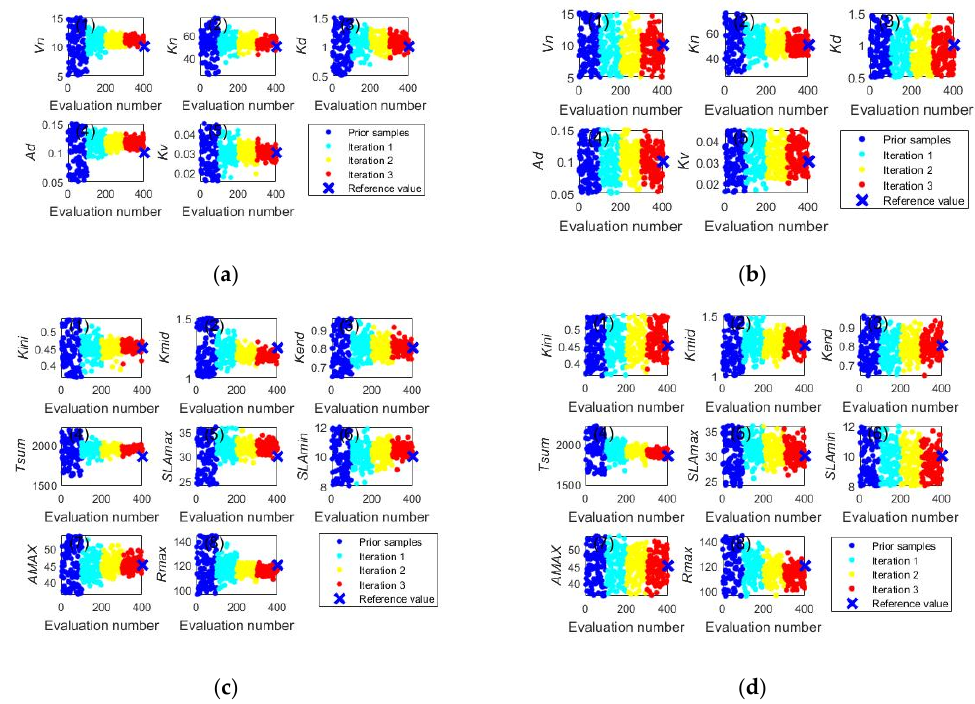
Figure 3. Trace plots of soil nitrogen transformation parameters and crop parameters obtained by the ILUES ( left column ) and ESMDA ( right column ) algorithms. The blue cross symbol at the right side of each figure signifies the referred value of each parameter. (a) Soil nitrogen transformation parameters derived by ILUES; (b) Soil nitrogen transformation parameters derived by ESMDA; (c) Crop parameters derived by ILUES; (d) Crop parameters derived by ESMDA.